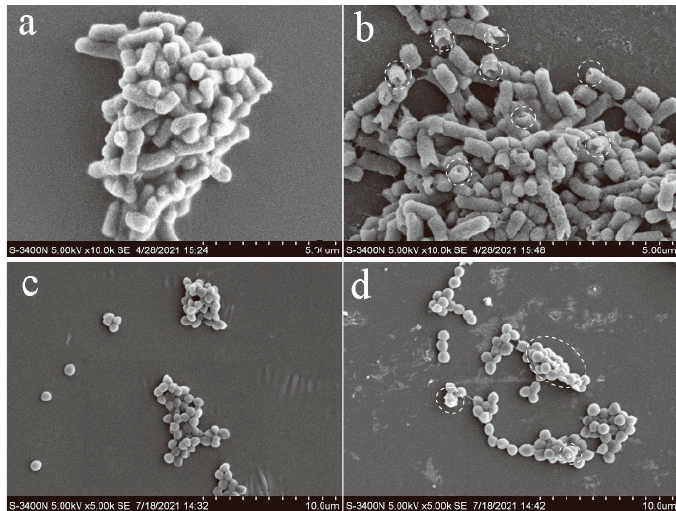
Figure 6. SEM images of: ( a ) E. coli without the P-doped CQDs, ( b ) with 1.23 mg/mL of P-doped CQDs, ( c ) S. aureus without the P-doped CQDs, ( d ) with 1.44 mg/mL of P-doped CQDs.